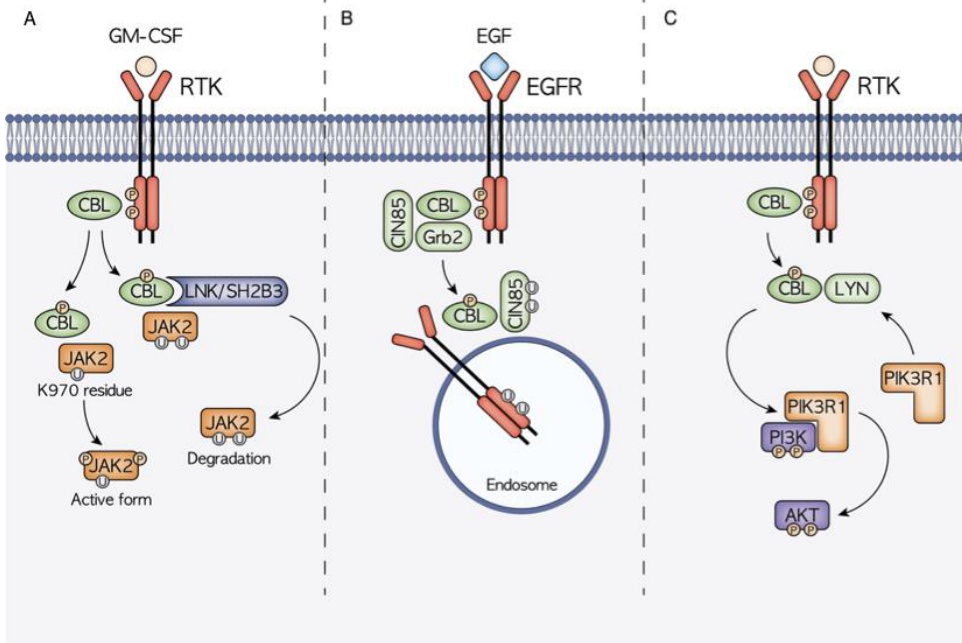
Figure 2. Schematic representation of the three main molecular mechanisms of CBL-mediated signal transduction modulation. ( A ) CBL is hypothesized to have a dual role in JAK2 signaling. On one hand, thanks to the interaction with the mediator LNK, CBL controls the ubiquitination and consequent degradation of JAK2, on the other hand it has been highlighted how the CBL-mediated ubiquitination at the JAK2 K970 residue causes JAK2 hyperphosphorylation and the consequent activation. ( B ) CBL is a well-known regulator of EGFR signaling, being able to induce EGFR ubiquitination and degradation. CBL binding can be mediated also by other adaptor proteins such as Grb2 and CIN85. ( C ) CBL activity also has a high influence on the PI3K/AKT signaling cascade. Through the interaction with LYN, it promotes the recruitment of PIK3R1 and the subsequent PI3K phosphorylation and activation.